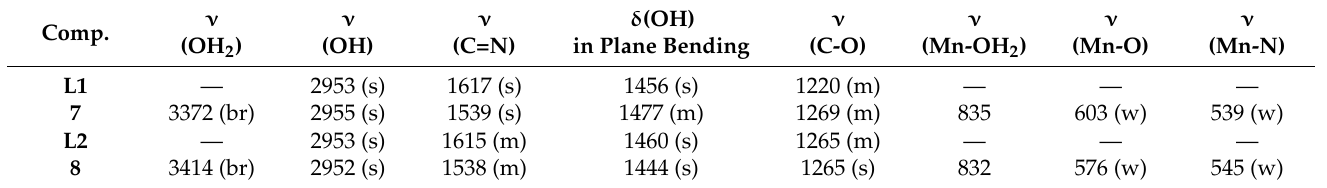
Table 2. FTIR spectral frequencies for the manganese (II) complexes and novel ONONu ligands.